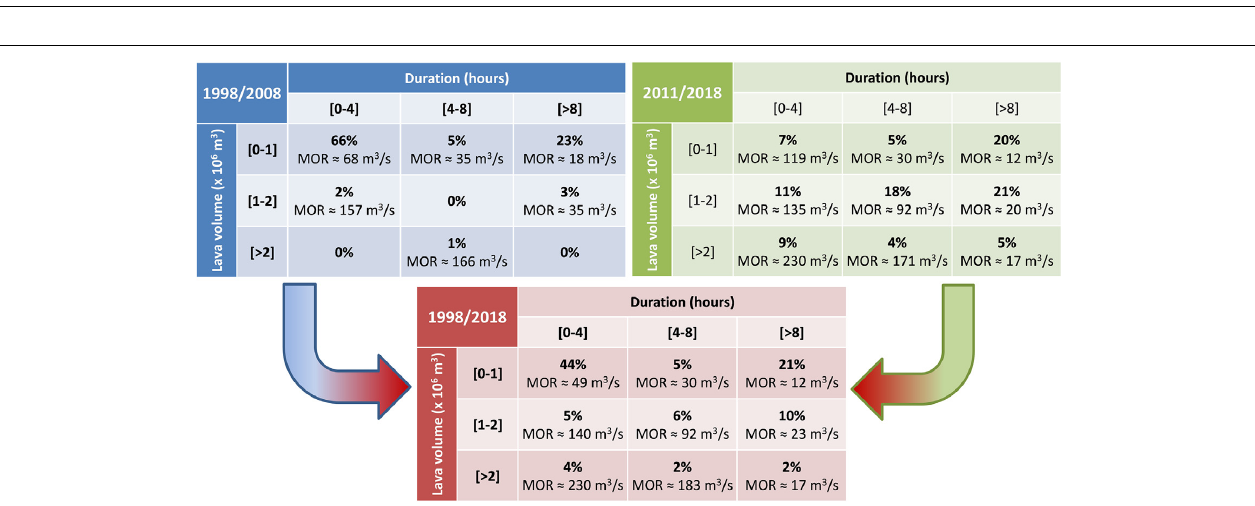
FIGURE 3 | (A) Box plots for duration (left) and lava volume (right) of SEC eruptions showing batches of data for Period I and II. Five values are displayed: the extremes, the upper and lower hinges (quartiles), and the median. Ordinates are in logarithmic scale. (B) Cumulative lava volume curve (blue line) estimated considering only SEC eruptions from September 1998 to August 2018 whose long-term supply rate is given by slope of the fitting curve (dashed blue line). Mean Output Rate - MOR (red diamonds) is calculated as the total volume erupted during the event divided by duration of event. The green bars highlight the five effusive flank eruptions of 2011, 2002–2003, 2004–2005, 2006 and 2008–2009.